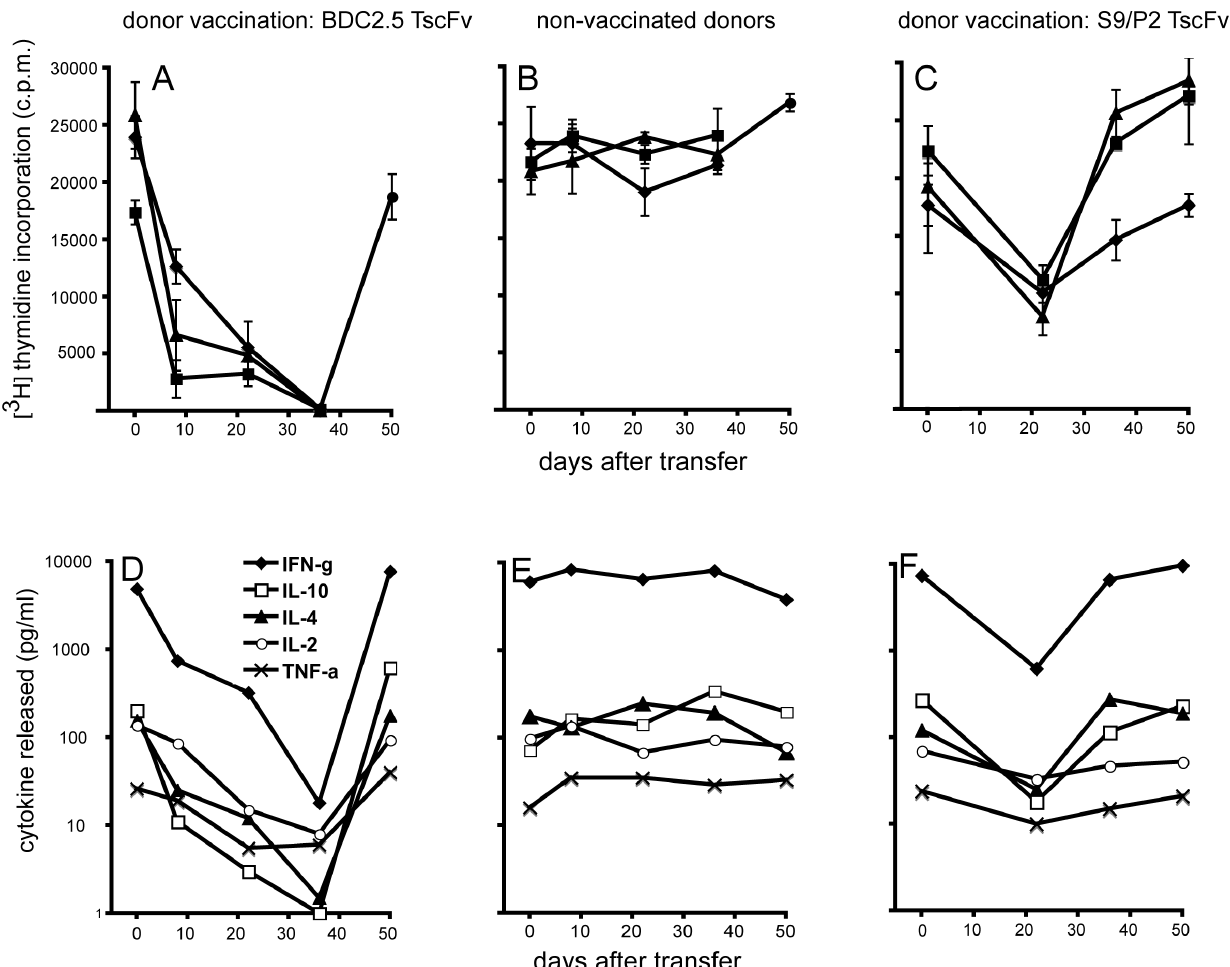
Figure 7. Effects in the BDC2.5 TCR transgenic NOD mouse (B-cells). To assess the effects B-cells derived from scFv-vaccinated mice would induce in vivo we transferred to BDC2.5 TCR tg recipients B-cells from NOD donors that had been vaccinated with TscFv BDC2.5 (A) or B-cells